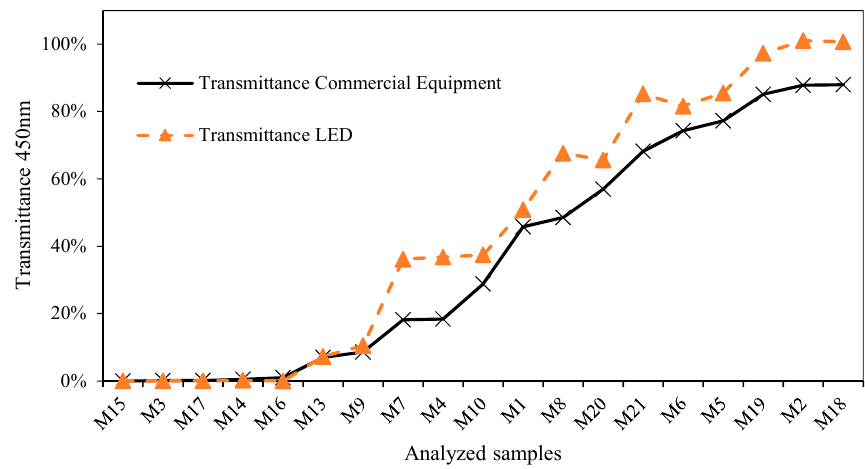
Figure 12. Comparison of transmittance obtained at 450 nm with the commercial equipment and the prototype developed based on an LED of dominant wavelength of 470 nm.